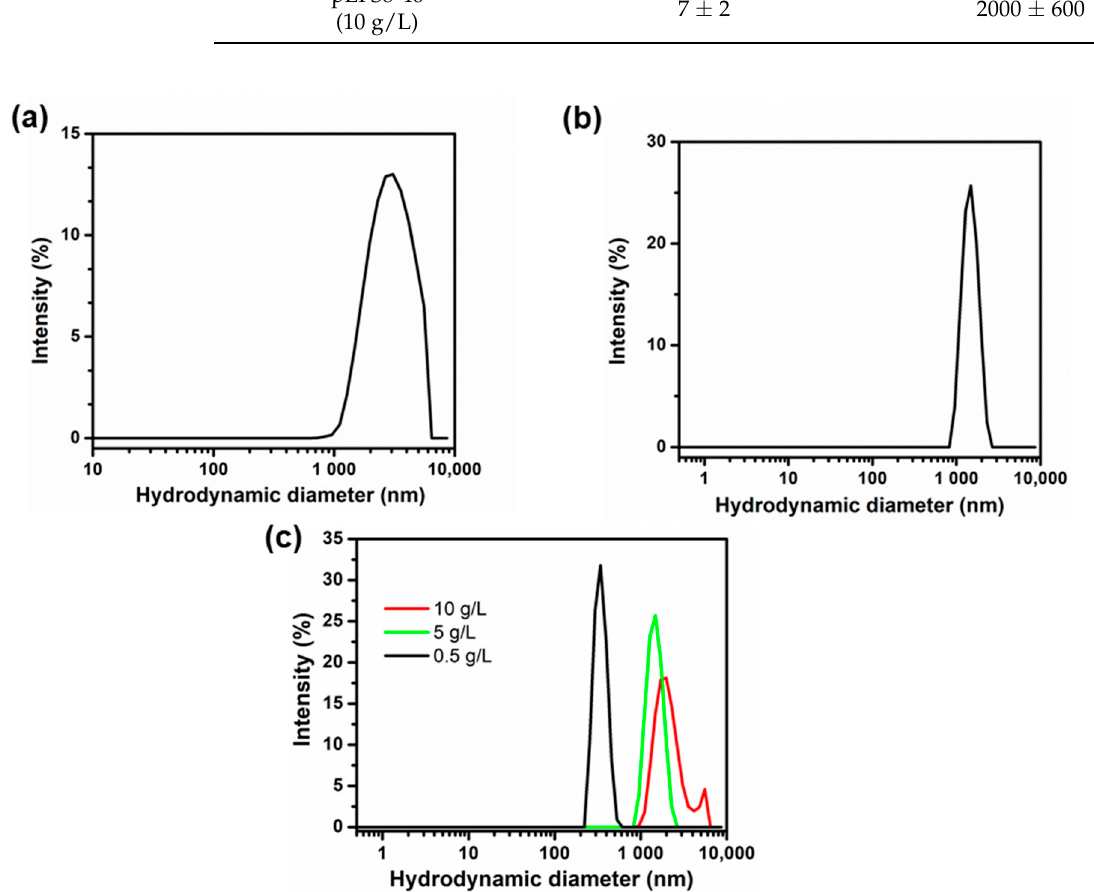
Figure 2. Intensity size distribution at 80 ◦ C for ( a ) pEFS8-26 and ( b ) pEFS8-46 aqueous solution at 5 g/L and ( c ) for pEFS8-46 at various